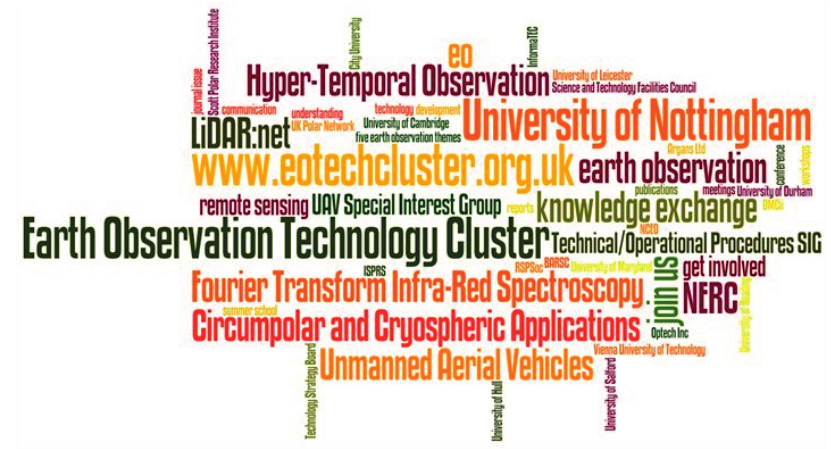
Figure 1. Earth Observation Technology Cluster word cloud, showing the initiative’s principal EO technology connections and